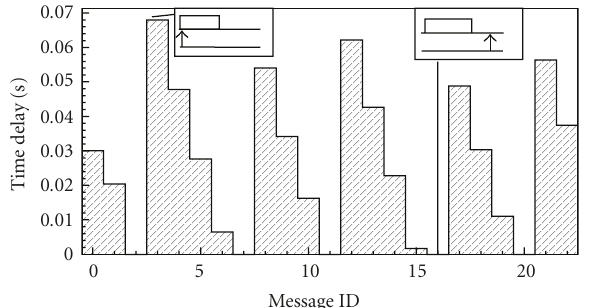
Figure 7: The saw-teeth-like pattern generated by the FCFS scheduling policy adopted for the sink kernel. The plot refers to UF = 0.8.